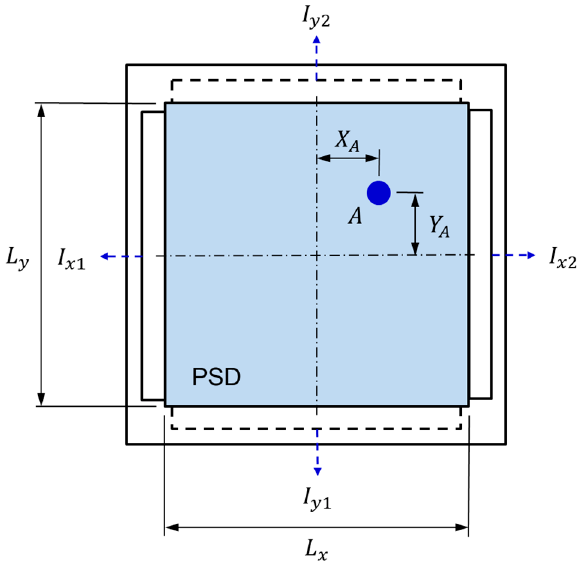
Figure 4. Position sensing principle of 2D − PSD.